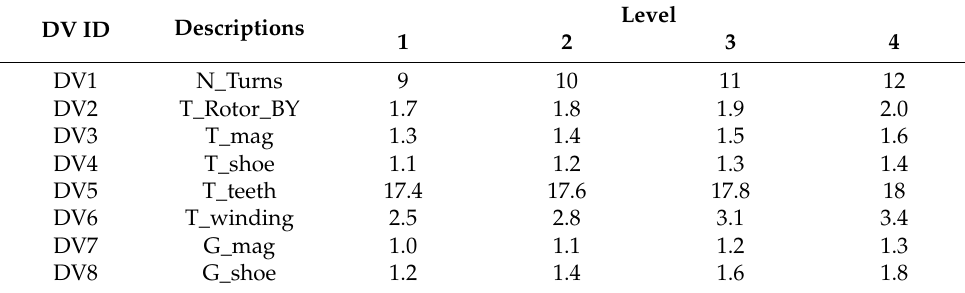
Table 2. Design variables and design areas for DRAFPM